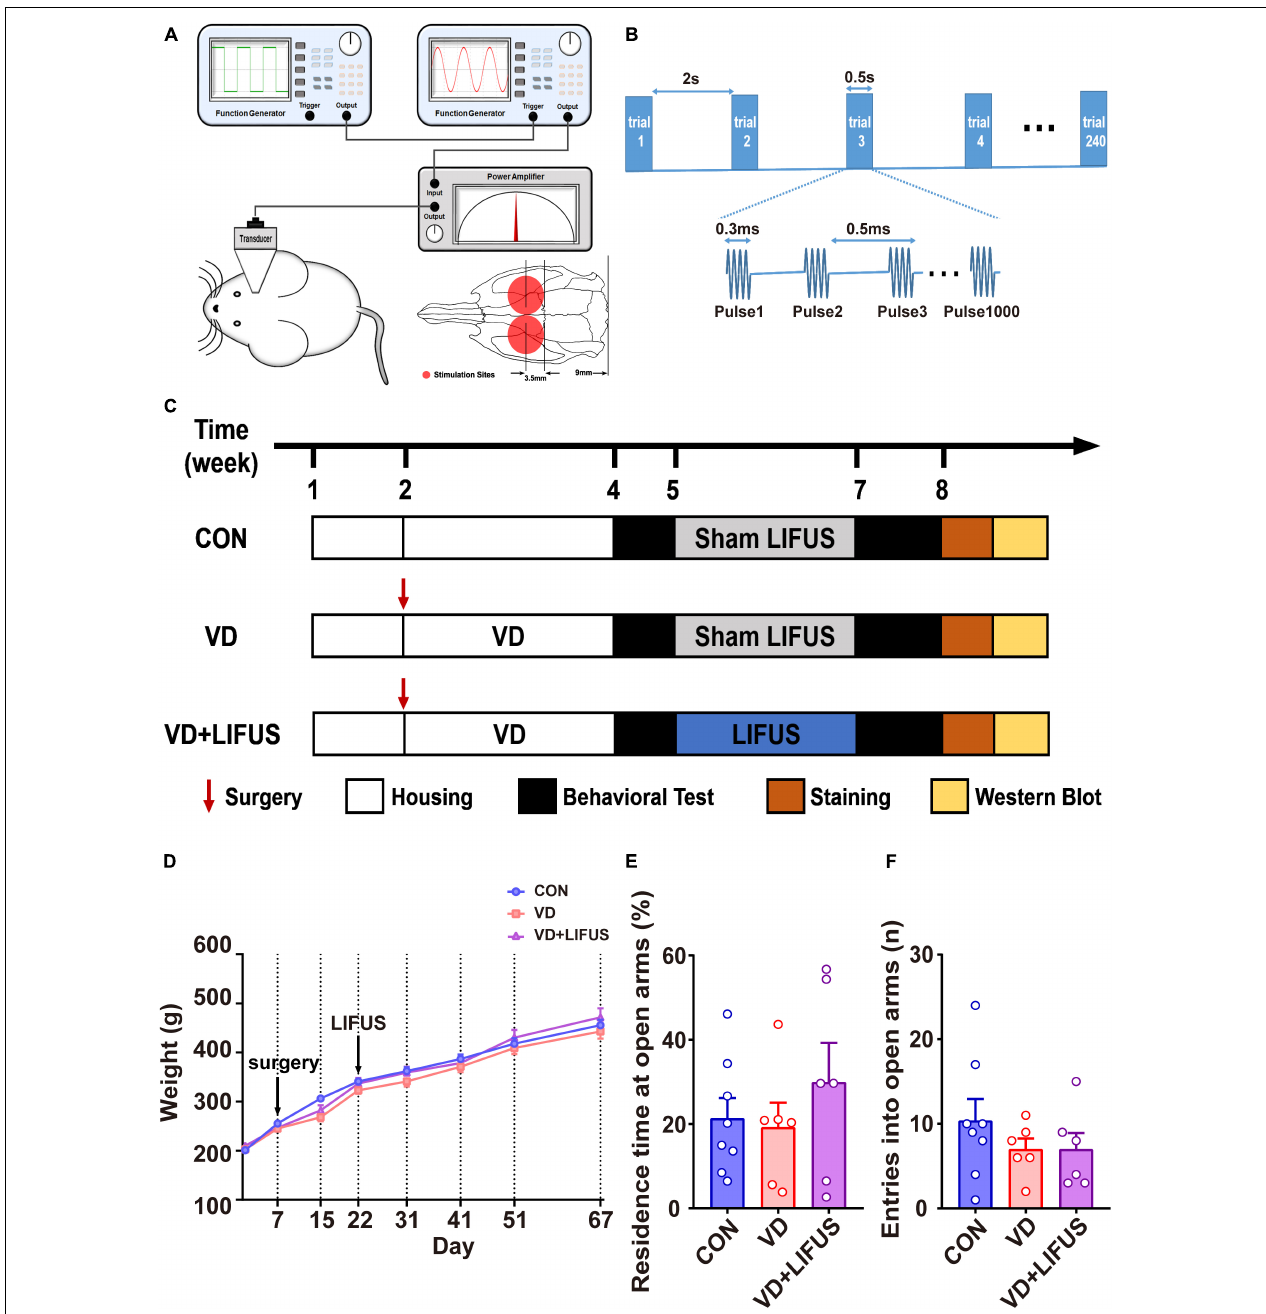
FIGURE 1 | (A) Illustration of LIFUS system. (B) Illustration of LIFUS parameters. (C) The timeline of the whole experiment. (D) Changes in body weight during the experiment (CON, n = 8; VD, n = 6; VD + LIFUS, n = 6). (E,F) The residence time at open arms (E) and entries into open arms in the OPT (CON, n = 8; VD, n = 6; VD + LIFUS, n =